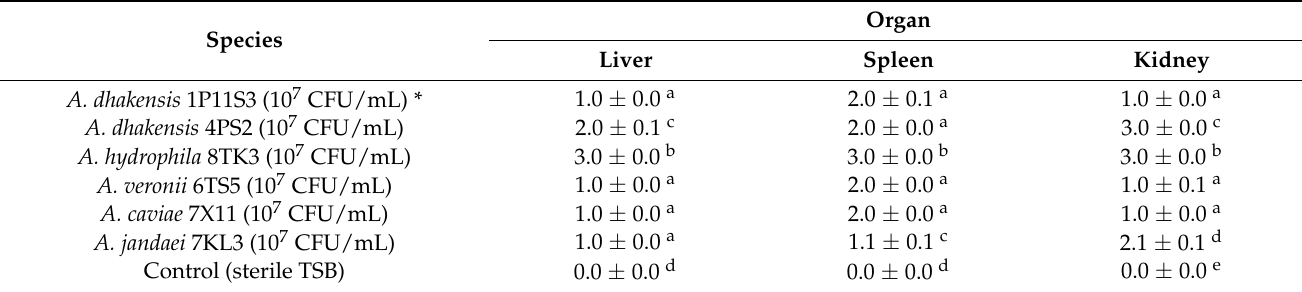
Table 2. Summary of histopathological changes scoring in liver, spleen and kidney of red hybrid tilapias following experimental infection by Aeromonas spp. Organ Species Liver Spleen